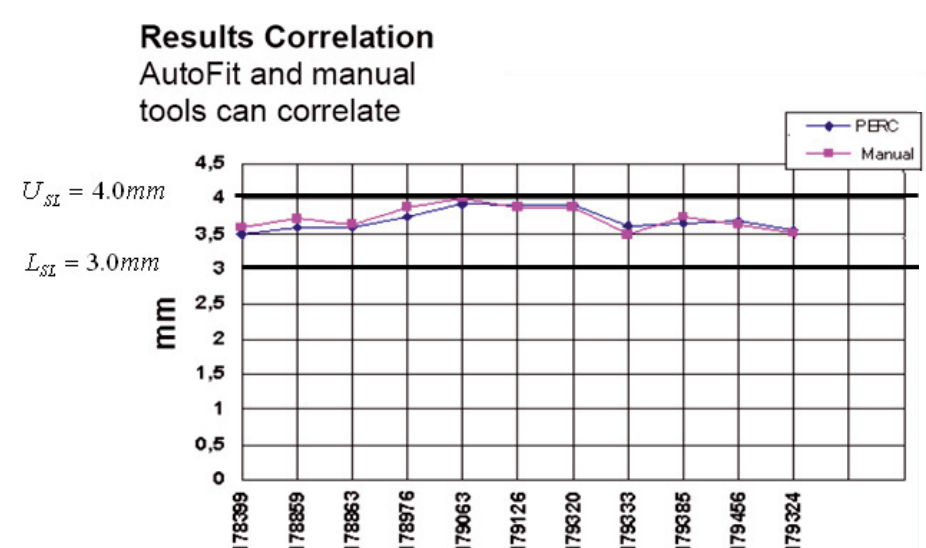
Fig. 1. Measurement of the gap in vehicle closure panels using two measurement methods (“PERC” and “Manual”) [12]. gap should lie in the region of permissible values 3